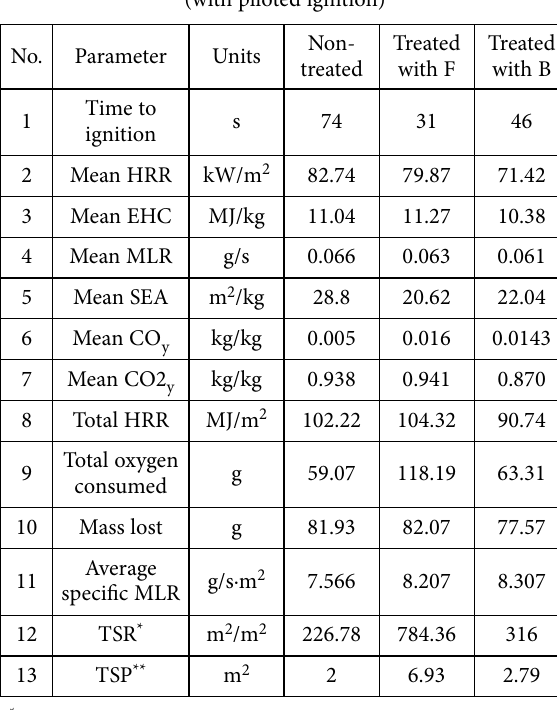
Table 3. Some characteristic parameters obtained during the combustion of non-treated and treated pine timber (with piloted ignition)